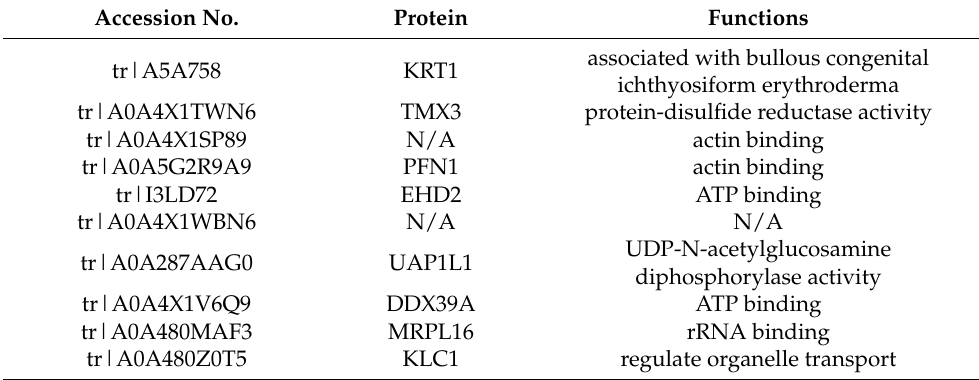
Table 2. Top 10 up-regulated proteins induced by PCV 2 Cap digestion.